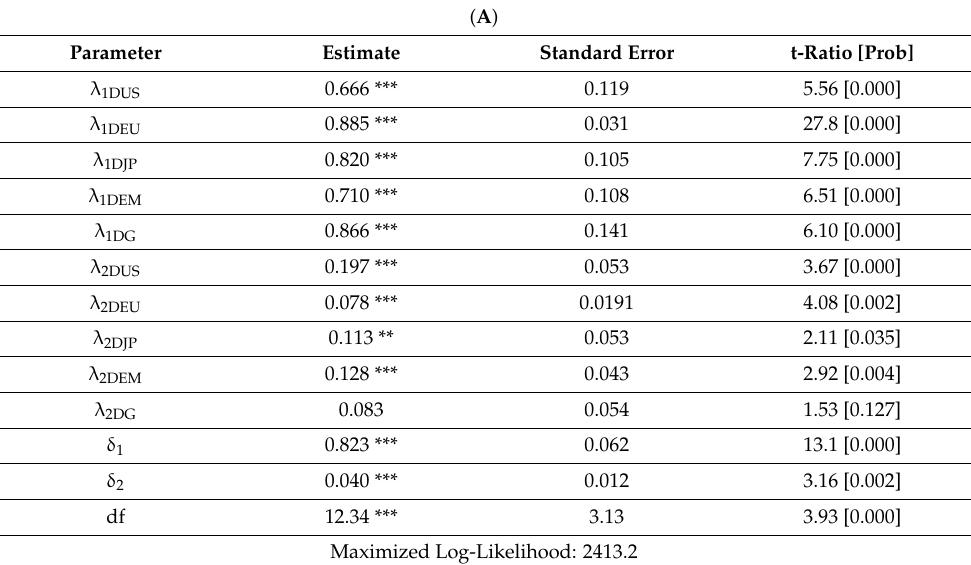
Table 3. ( A ) Multivariate Garch (1,1)—DCC Model: Gold and Global Stock Returns Sample: 2000m11– 2021m7 (249 Observations). ( B ) Multivariate Garch (1,1)—DCC Model: Swiss Franc and Global Stock Returns Sample: 2000m11–2021m7 (249